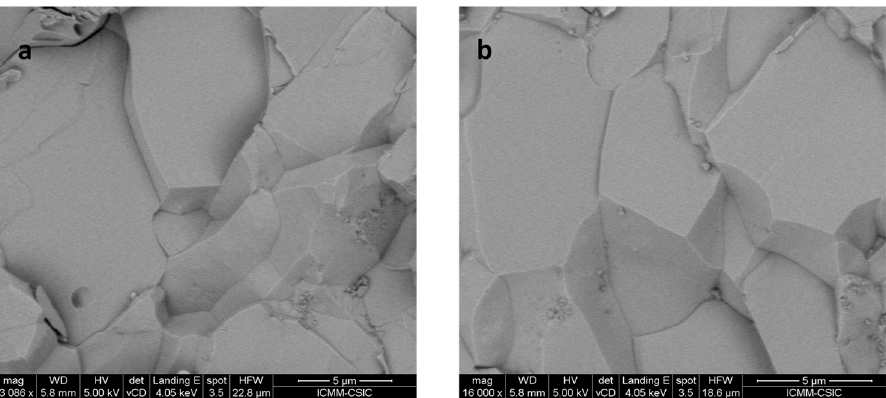
Figure 5. SEM image of Gd 0.033(2) Co 4 Sb 12 exhibiting well-sintered grains with no porosity due to the high-pressure preparation, with magnification ( a ) 13,086 × and ( b ) 16,000 ×